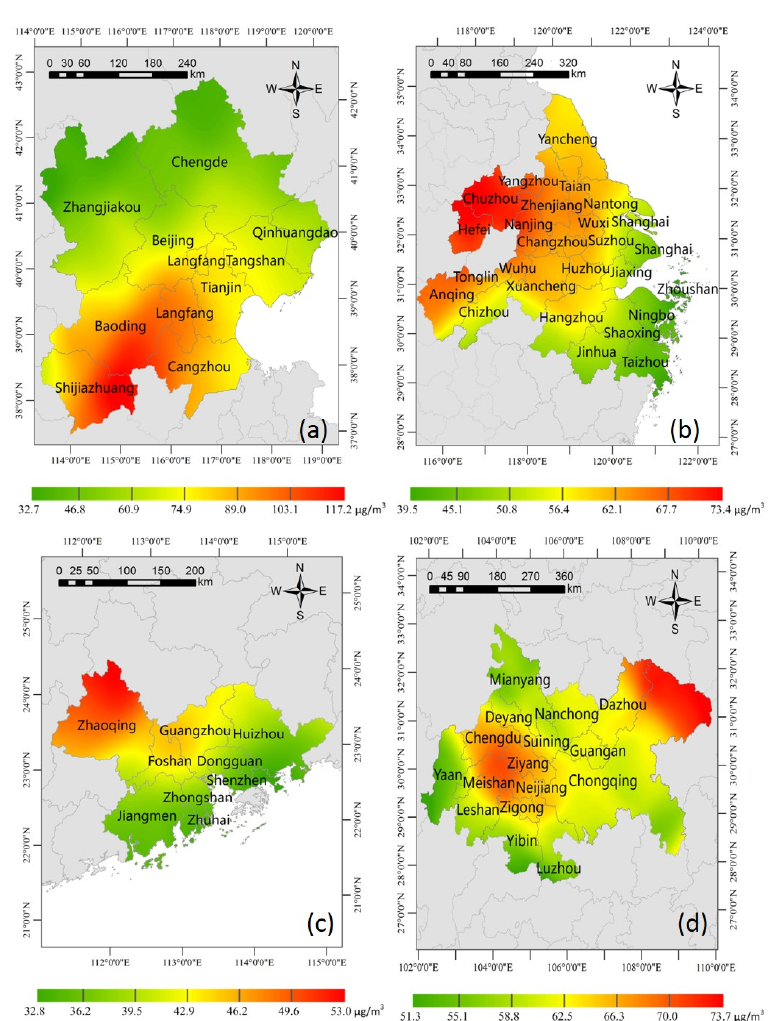
Figure 2. The spatial patterns of PM 2.5 concentrations in the four urban agglomerations. ( a ) Beijing-Tianjin-Hebei; ( b ) Yangtze River delta; ( c ) Pearl River delta; and ( d ) Chengdu-Chongqing. Each subfigure has a different color scale to highlight the spatial variability across the corresponding urban